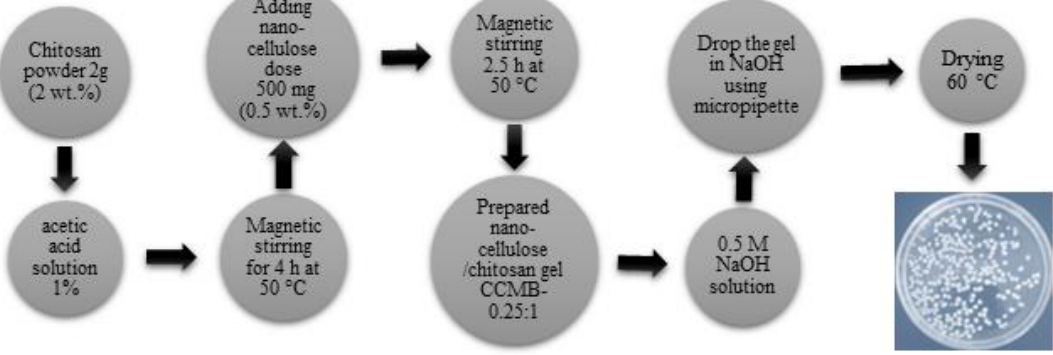
Figure 3. The preparation process for nanocellulose/chitosan beads (CCMB-0.25:1).